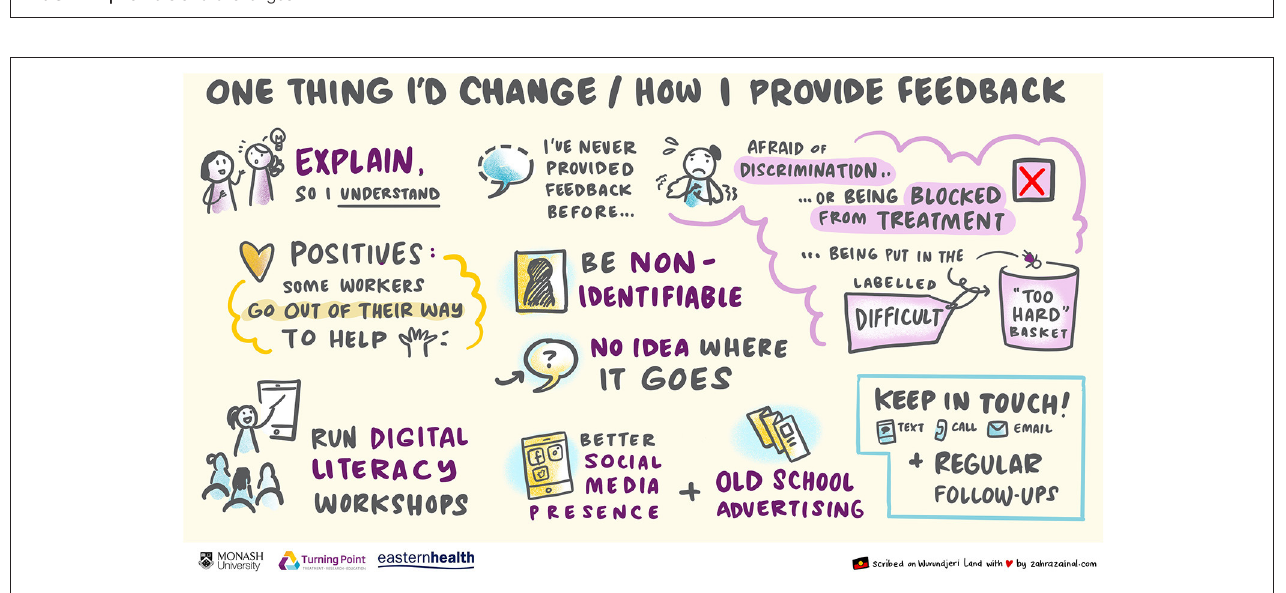
FIGURE 1 | Barriers and challenges.